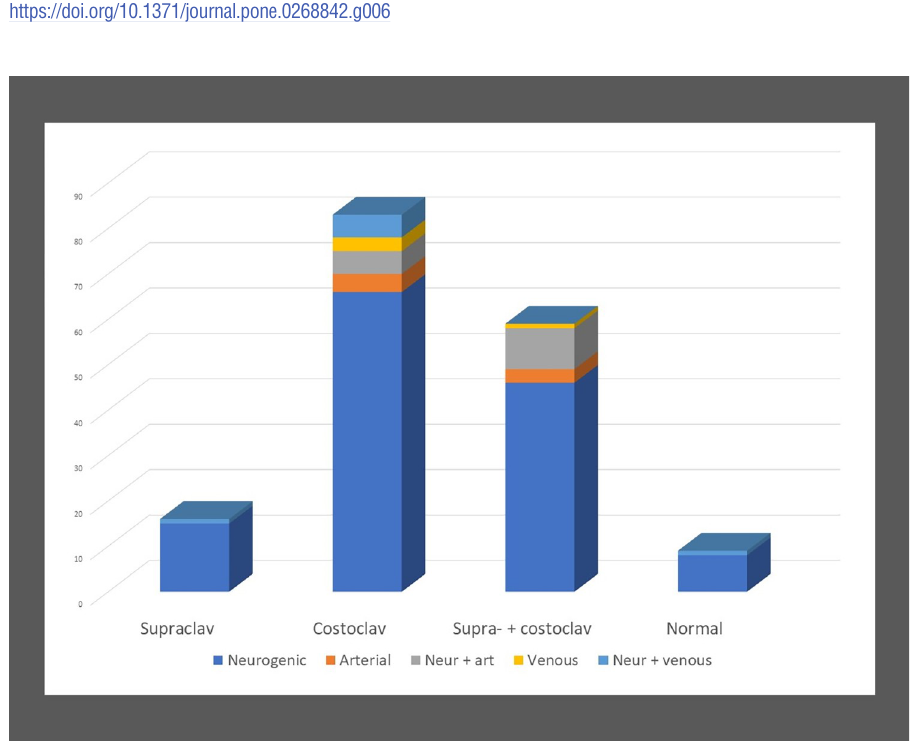
Fig 7. Type of symptoms and site of compression in TOS. Note that the most common site of compression was the costoclavicular space, and the most common type was neurogenic TOS. The Y axis denotes the number of patients.